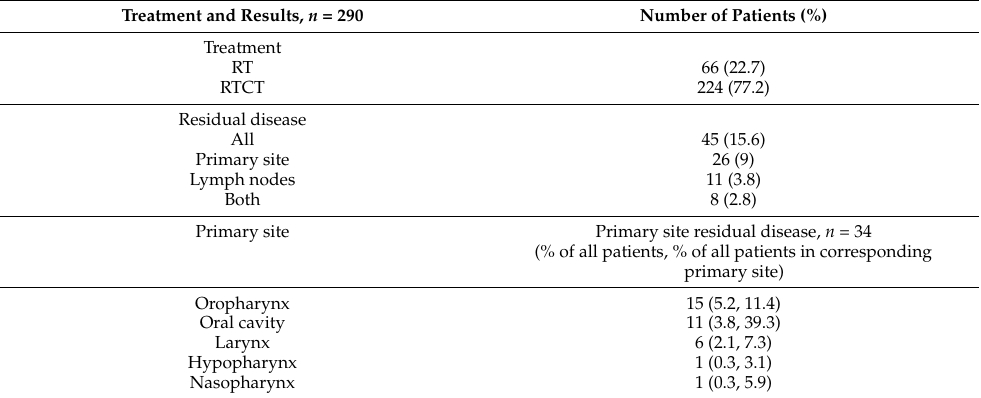
Table 2. Treatment and